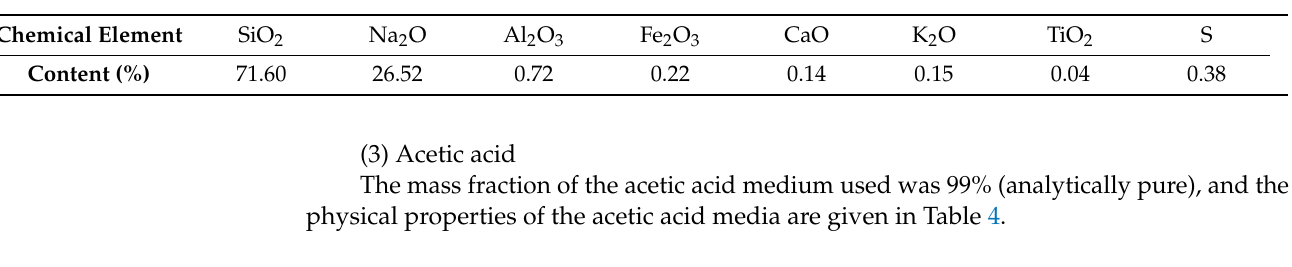
Table 4. Physical properties of acetic acid.